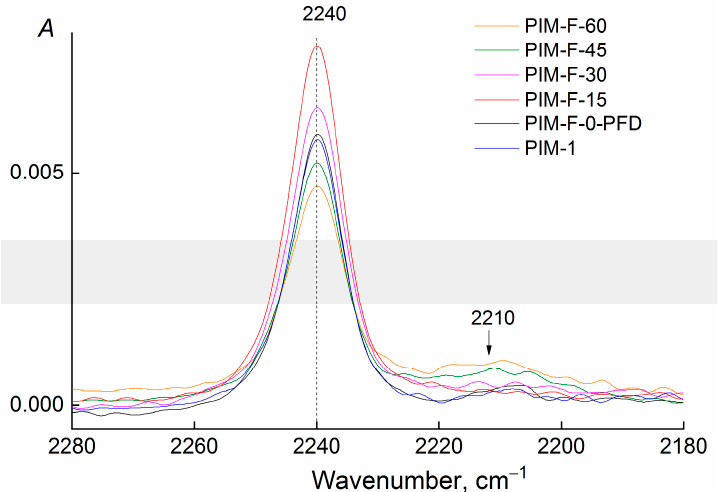
Figure 4. The absorption region of C ≡ N bonds in the ATR-IR spectra of the films before and after fluorination.